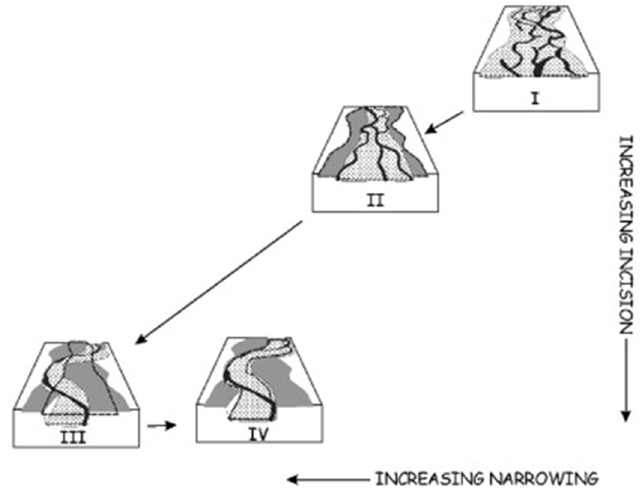
Figure 2. Schematic diagram of the morphological dynamic which is happening in the studied rivers (from [26]). Dotted areas represent the river channel, while grey colour represents the abandoned areas. The four patterns from I to IV represent four subsequent stages of river morphological dynamic in the Brenta, Piave, and Tagliamento Rivers from the early nineteenth or the twentieth centuries (pattern I) to the present-day morphology (pattern IV).